Question: Write a caption explaining this figure to a reader.
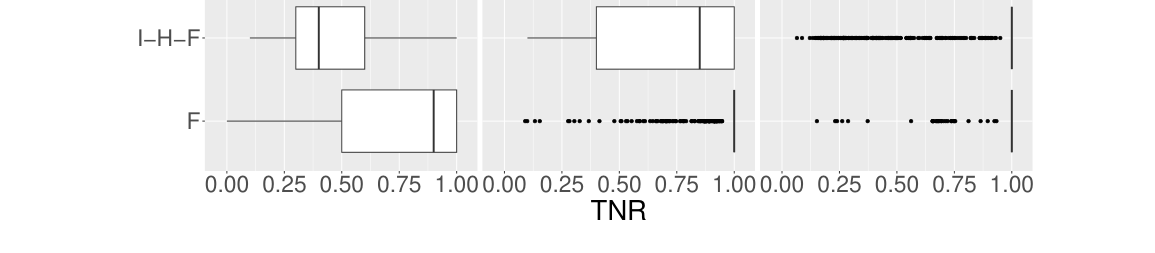
Answer: Simulation 1: boxplots for TNR (the true negative rate for the input variables) for each method by sample size.